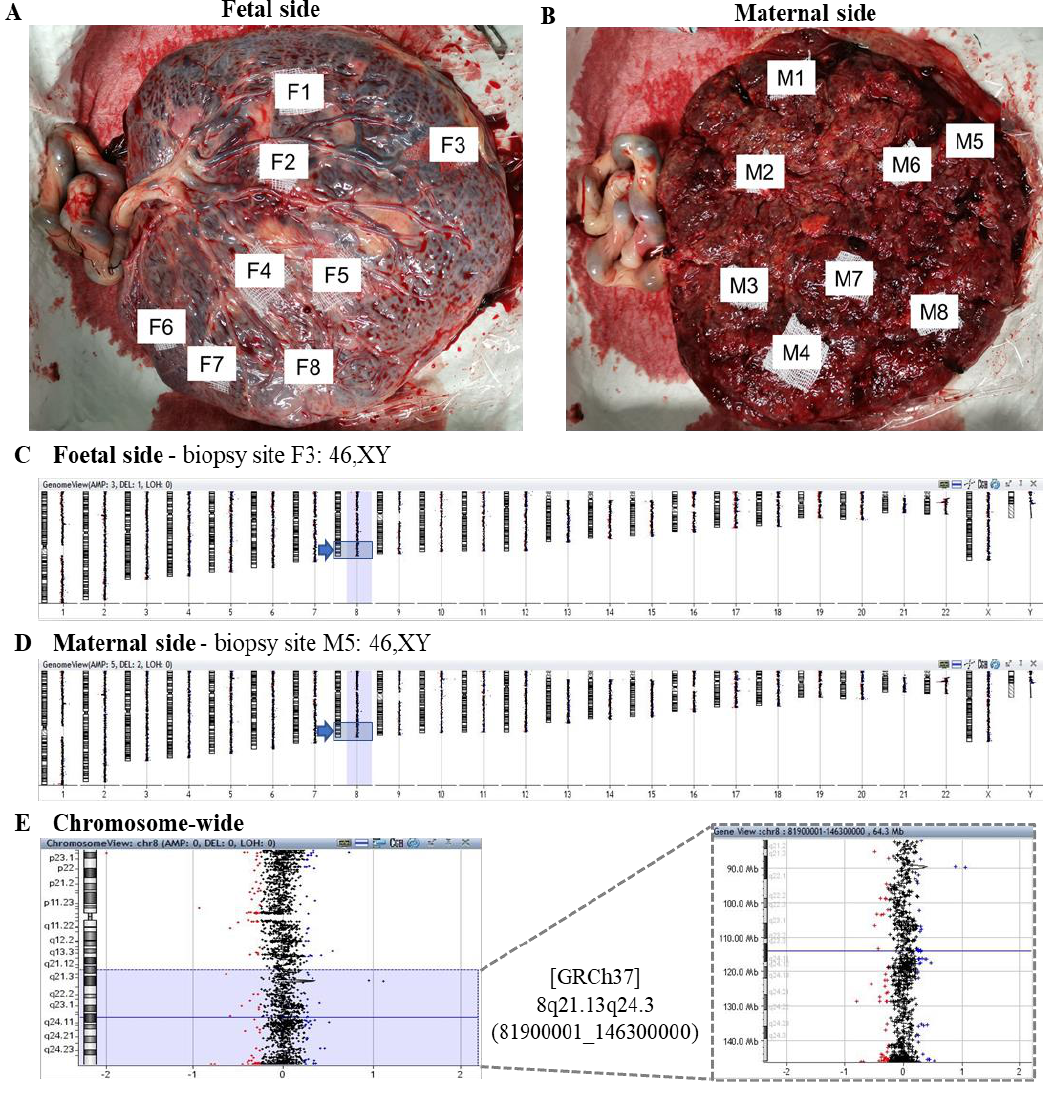
Figure 5. Postnatal CMA confirmation of one MET pregnancy by placental multiple biopsies. ( A , B ) Biopsies on eight sites from each side of the placenta. Male control as a reference for chromosomal microarray analysis, showing an example of absence of segmental chromosomal aneuploidy on ( C ) the fetal side view, ( D ) the maternal side genome view, ( E ) and the chromosome and regional view of [GRCh37] 8q21.13q24.3 (81900001_146300000), with no chromosomal